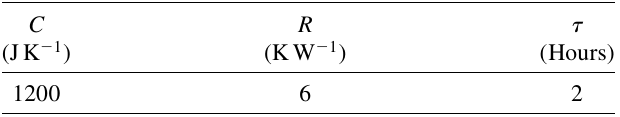
TABLE I. Theoretical thermal capacitance, C , thermal resis- tance, R , and time constant (cid:11) .